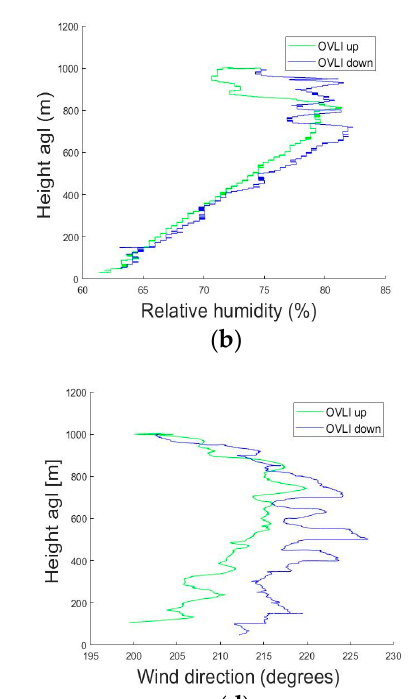
Sensors 2019 , , x FOR PEER REVIEW 14 of 21 Table 3. Mean absolute error of east and north wind speed. Standard deviation of the difference between east (or north) wind component measured respectively by the 60 m mast and OVLI-TA. East Wind Component (m/s) North Wind Component (m/s) MAE 1.0 1.0 After flights in Lannemezan, OVLI-TA was operated during the DACCIWA campaign for profiling temperature, humidity, wind speed, and direction in the ABL between 10 and 1000 m agl. Figure 13 illustrates the observations of temperature and wind during the flight on July 15, 2016 that started at 16:45 UTC and lasted for 40 min. Stacked back and forth sequences were made on a racetrack pattern, and a continuous profile was obtained from a helical pattern. ( a ) ( b ) Figure 13 . Air temperature ( a ) and wind vector ( b ) measured on July 15, 2016 at 16:45 (UTC). The quality of the measurements was checked by comparing profiles during the ascending and descending parts of the flight. This is shown in Figure 14, for the wind speed and direction, relative humidity, and temperature. The differences in relative humidity below 600 m were within the expected accuracy of the sensor. The large fluctuations above 600 m were related to the so-called entrainment zone, which lies in the upper part of the ABL, and contains a mixture of air parcels coming from the well-mixed layer below, and from the upper layer above, the latter being